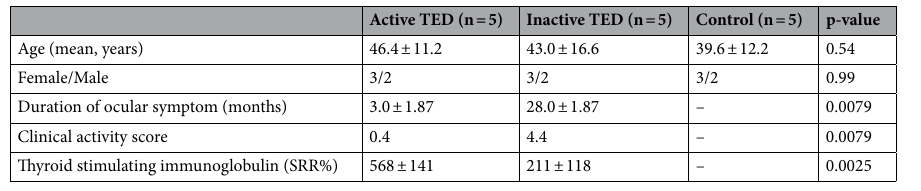
Table 1. Detailed clinical and ophthalmologic characteristics of the discovery study population. TED thyroid eye disease, SRR sample-reference ratio.